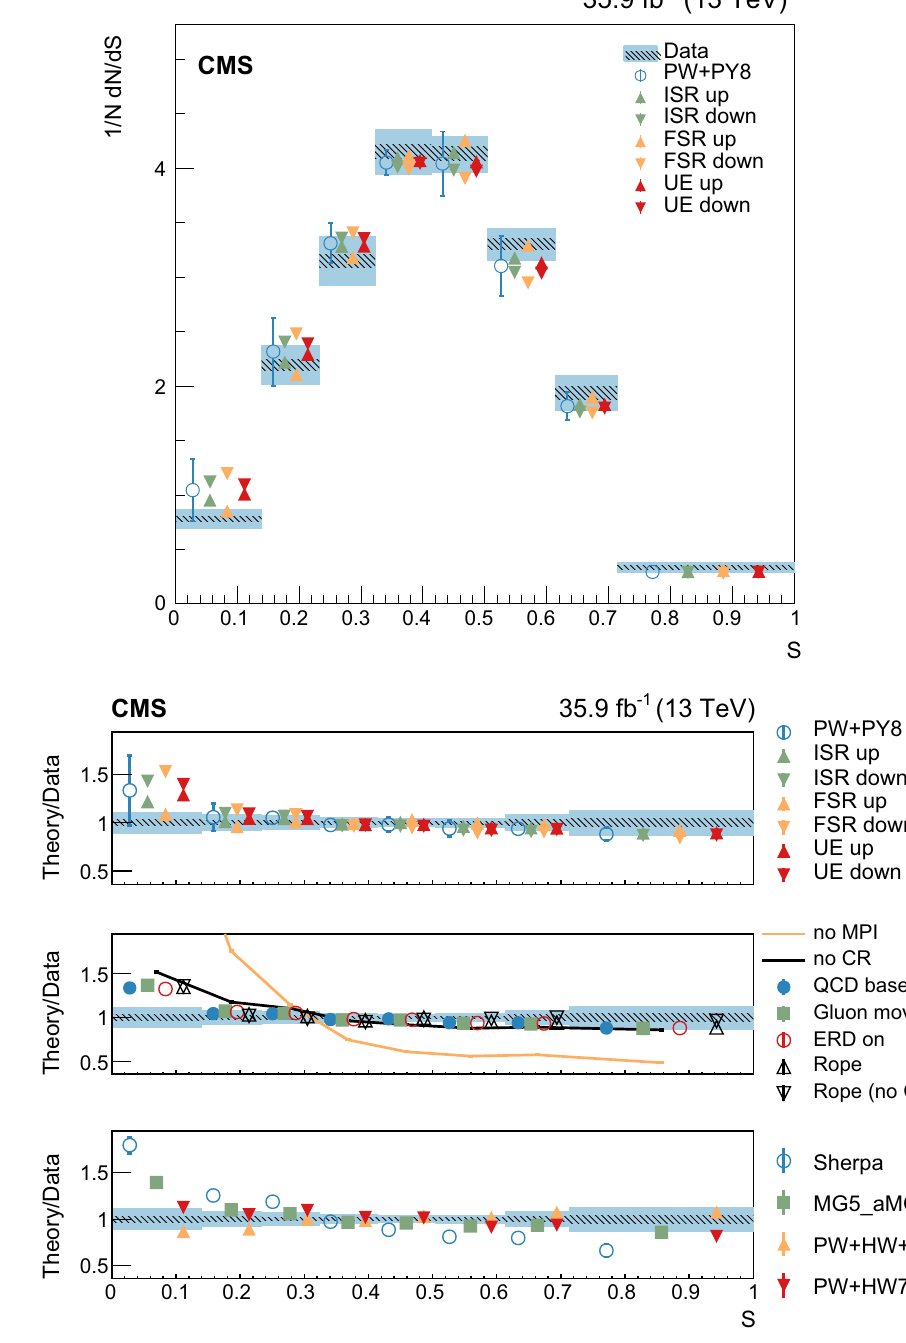
Fig. 10 Normalized differential cross section as function of the sphericity variable, compared to the predictions of different models. The conventions of Fig. 4 are